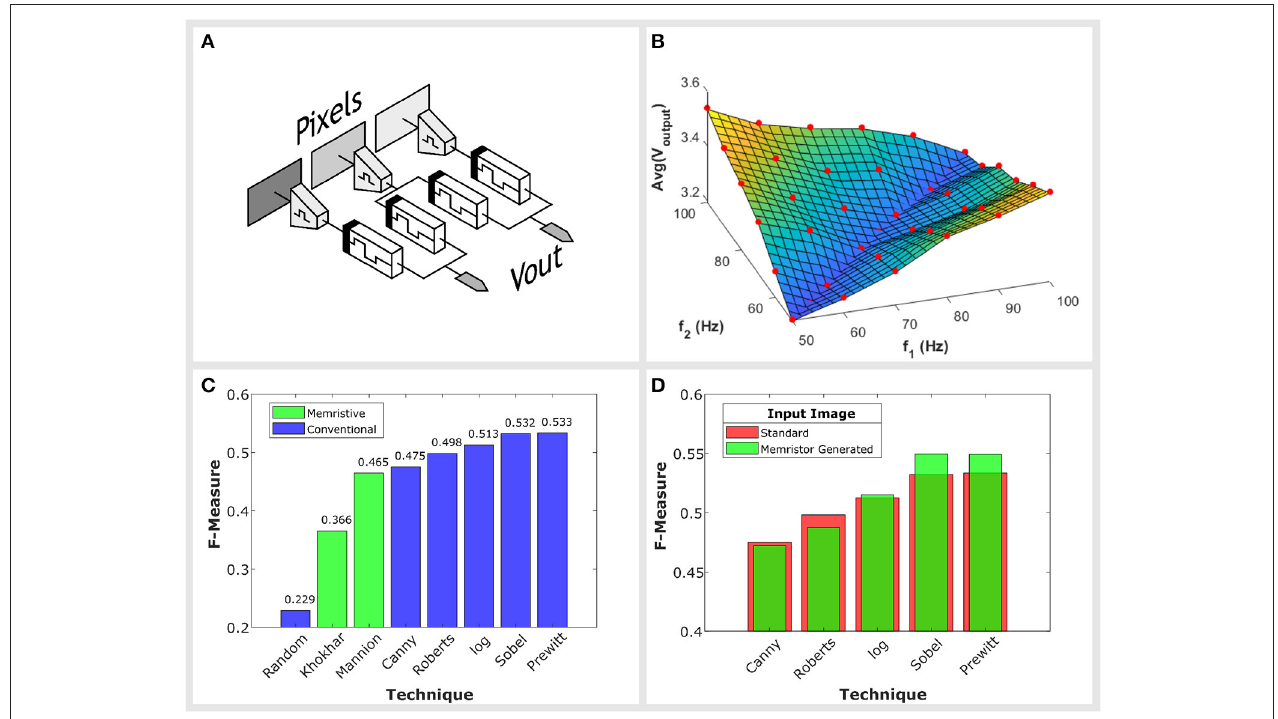
FIGURE 3 | (A) An illustration of how edge detection would be implemented. The circuit is placed between two neighboring pixels. Large differences in pixel values will produce output spikes with larger amplitudes. (B) The look-up map describing our circuit’s behavior. The average amplitude of output spikes above a threshold is plotted along the z axis. We use this look-up table during simulations. It approximates the circuit’s output for any given pair of input frequencies. The sampling points from which this map was interpolated from are illustrated with red circles. (C) Benchmarking results on the BSDS500 dataset. The distribution of F-Measures, defined in Arbeláez et al. (2011) are plotted for memristive techniques (green) and standard operators (blue). The results are obtained from the set of 200 test images provided by BSDS500. (D) Comparison of F-Measure scores for a set of operators using both the original test images and images produced by our own circuit as their input. An improvement in performance is observed over the Prewitt, Sobel, and log